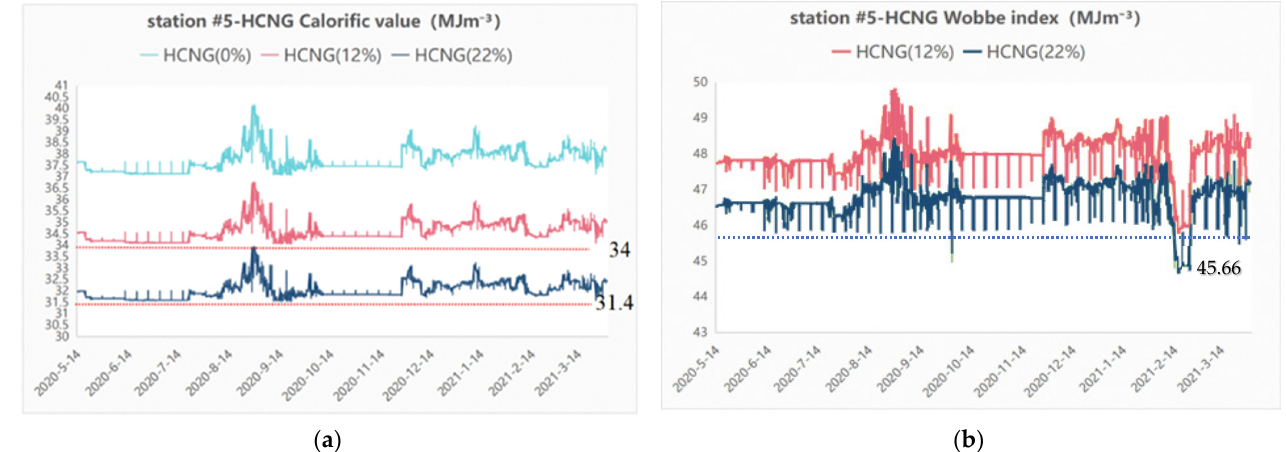
Figure 7. ( a ) Calorific value of natural gas source station #5 measured between 2020.5 and 2021.3 . ( b ) Wobbe Index of natural gas source station #5 measured between 2020.5 and 2021.3. The light blue line in Figure 8a is the real calorific value of gas source station #6. The gas source of gas source station #6 is West Second Gas. Its characteristic is that the calorific